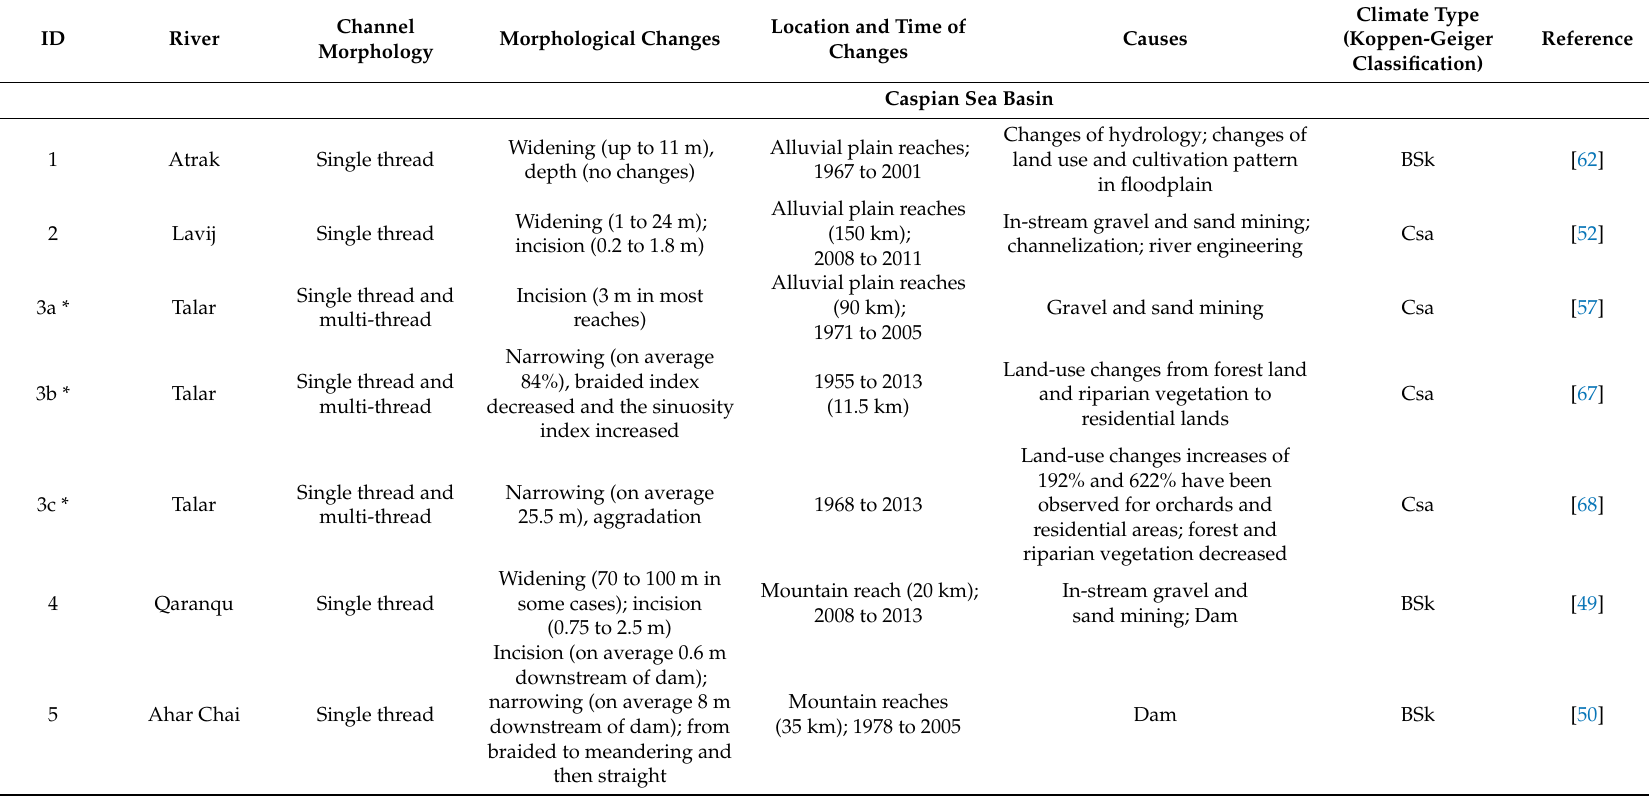
Table 2. Channel adjustments in Iranian rivers and relative